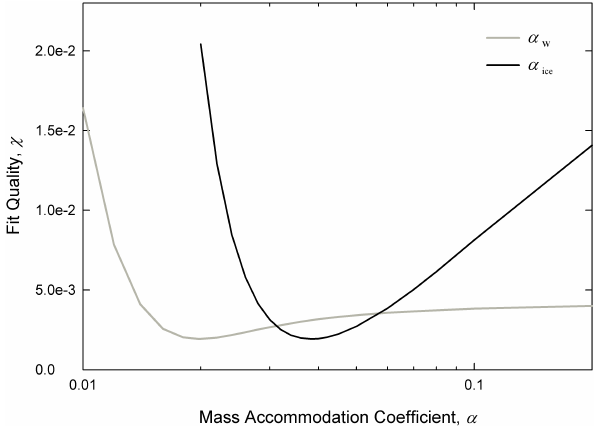
Fig. 8. Variation of χ with changes in mass accommodation coef- ficients α w and α ice for the representative case of a partially frozen experiment for medium droplets at 235.7K.